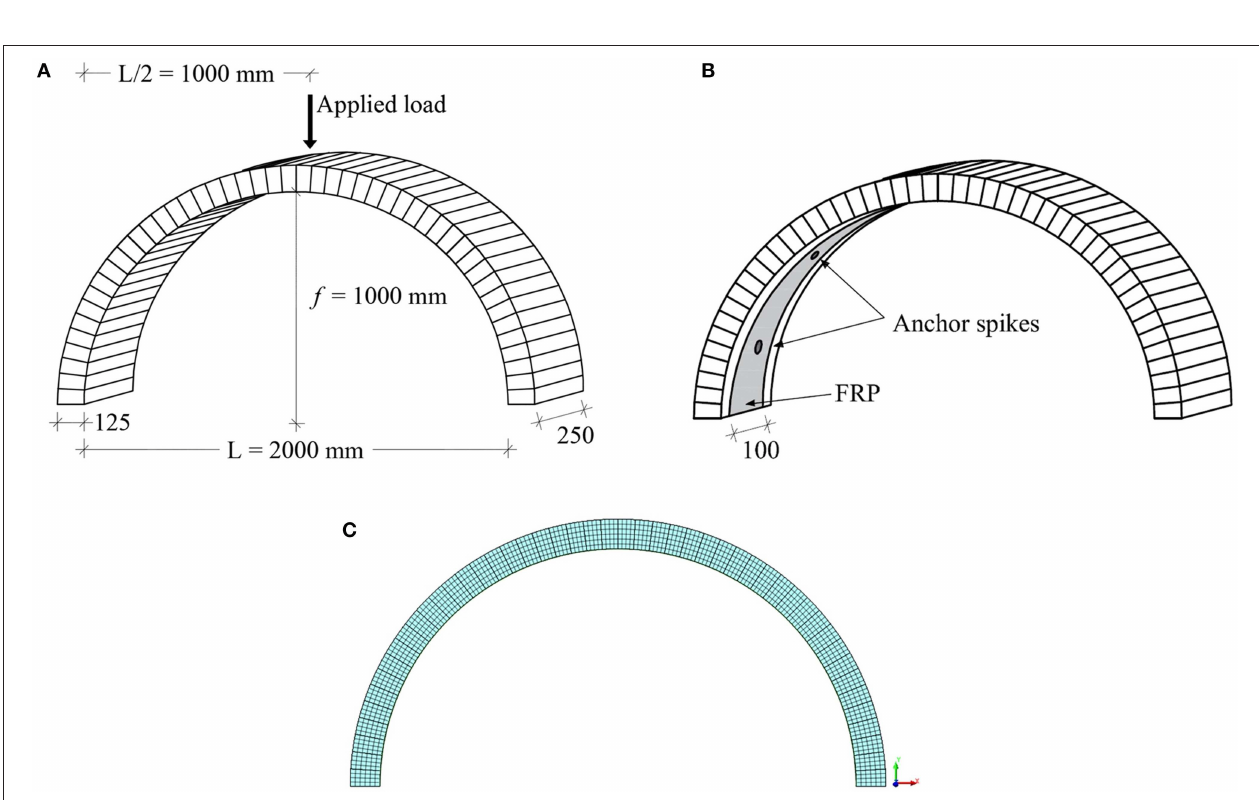
FIGURE 4 | (A) Geometrical properties of the masonry arches tested by Borri et al. (2011); (B) FRP strengthening configuration according to Borri et al. (2011); (C) Mesh adopted for the finite element analysis.